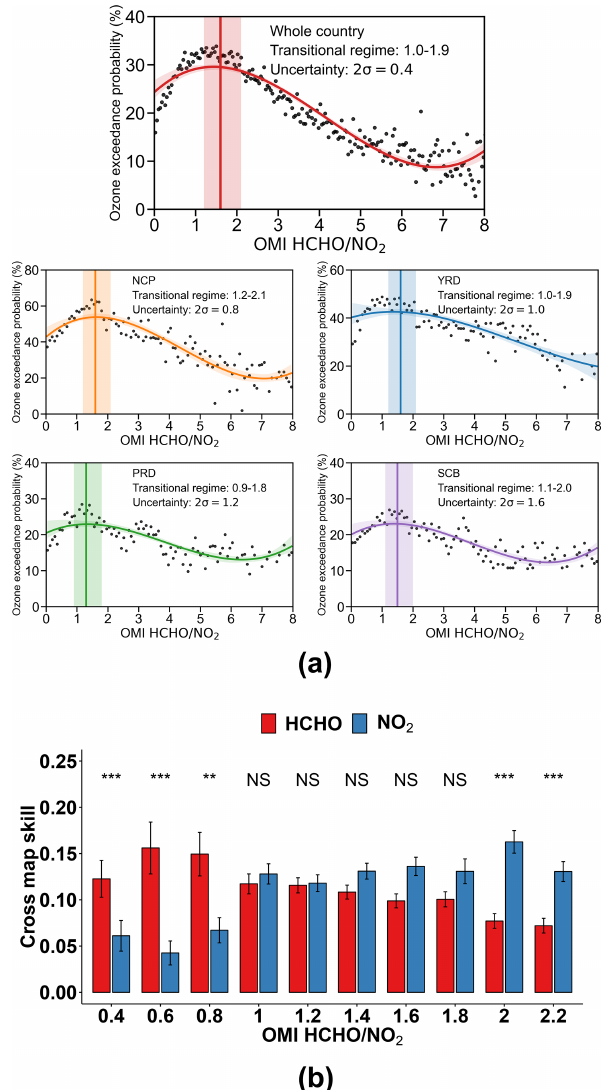
Figure 8. (a) Fitting ozone exceedance probability to HCHO / NO 2 through the third-order polynomial model. The curve indicates the fitting result of the third-order polynomial. The vertical line de- notes the maximum of the curve, and the shaded area represents the top 10% ozone exceedance probability. (b) The cross-map skill of HCHO and NO 2 on surface ozone (the skill of using HCHO and NO 2 for predicting surface ozone concentrations) at different ranges of HCHO / NO 2 . The symbols and texts above the bars are the re- sults of the Wilcoxon test. ∗∗∗ and ∗∗ indicate that the difference was significant at the p = 0 . 01 and 0.05 confidence level, respec- tively. NS suggests non-significant differences.